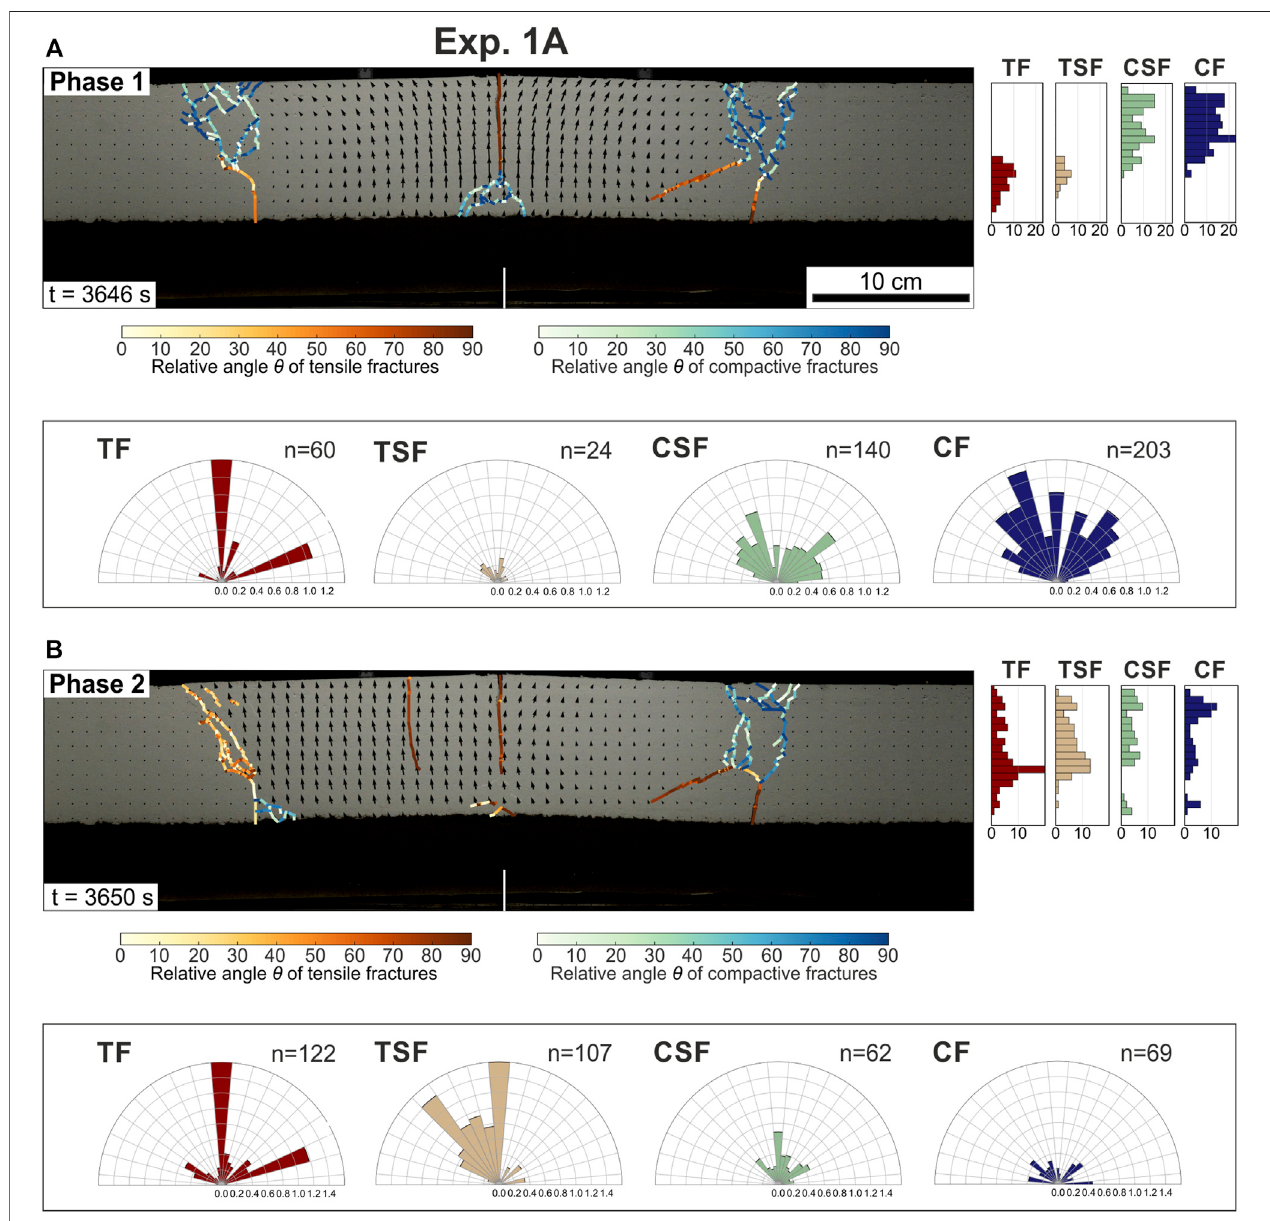
FIGURE8| Resultsofthefracturemodeanalysisofthe2Dexperiment1Afor (A) phase1and (B) phase2showingtheopeningmodeofthefracturescolor-coded. The opening mode is determined by the relative angle θ between the dip of the fracture and the displacement vectors (black arrows). If θ is larger than 45 ° , the fracture is dominated by tensile (red) or compactive (blue) movement, respectively. In case θ is smaller than 45 ° , the fracture is dominated by tensile-shear (orange) or compactive shear(green), respectively. Thebar plots totheright display theamount ofthespeci fi cfracture types forcertain depthintervals (onlywing fractures included). Rose diagramsdisplaythedipangles α ofthetensile(TF),tensile-shear(TSF),compactive(CF)andcompactive-shearfractures(CSF)normalizedbythelengthofeachfracture segment.